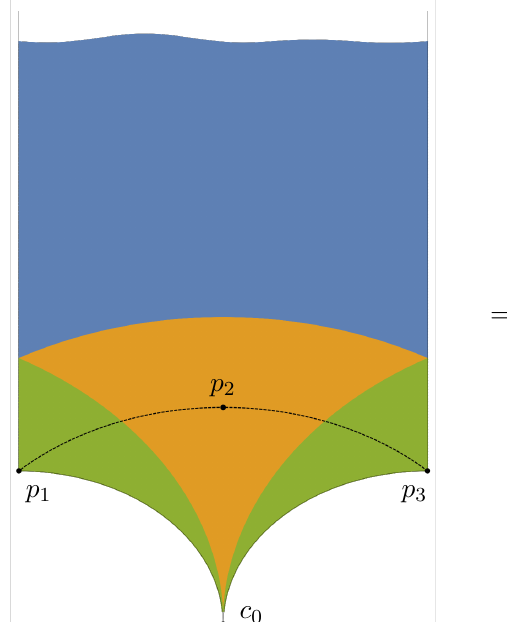
(2) /F . The marked points are 0 2 √ = − ¯ p . p = i/ 2 is the fixed 1 3 2